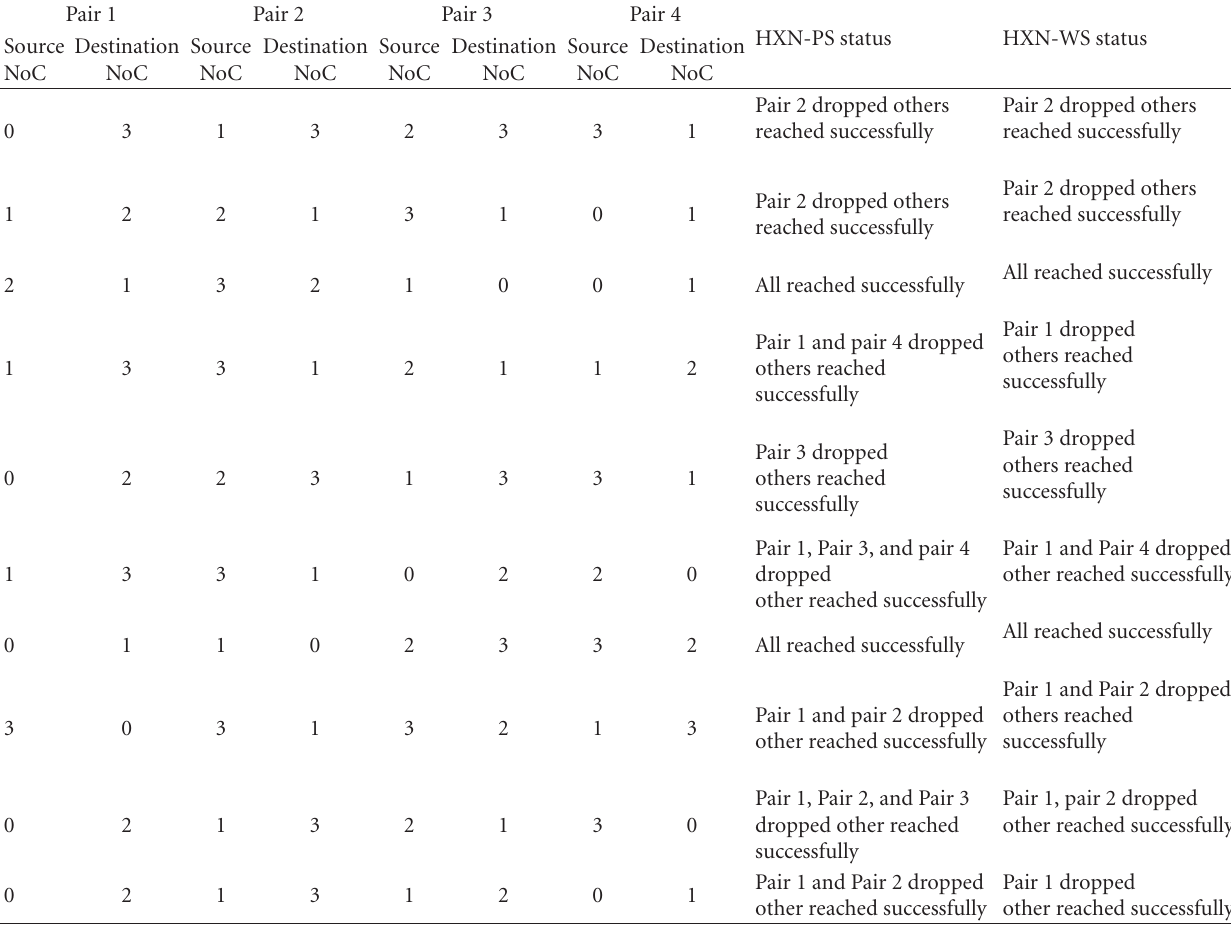
Table 13: The following source destination pairs of NoCs are used to show 62.5% and 72.5% e ffi ciency of the NiP (based on PNN, used as IoC). All source destination pairs delivered the information to the respective NoC. The following data does reflect the parallel communication among the NoCs using packet and wormhole switching algorithms. Some of the payload information are dropped in the network due to nonavailability of paths.